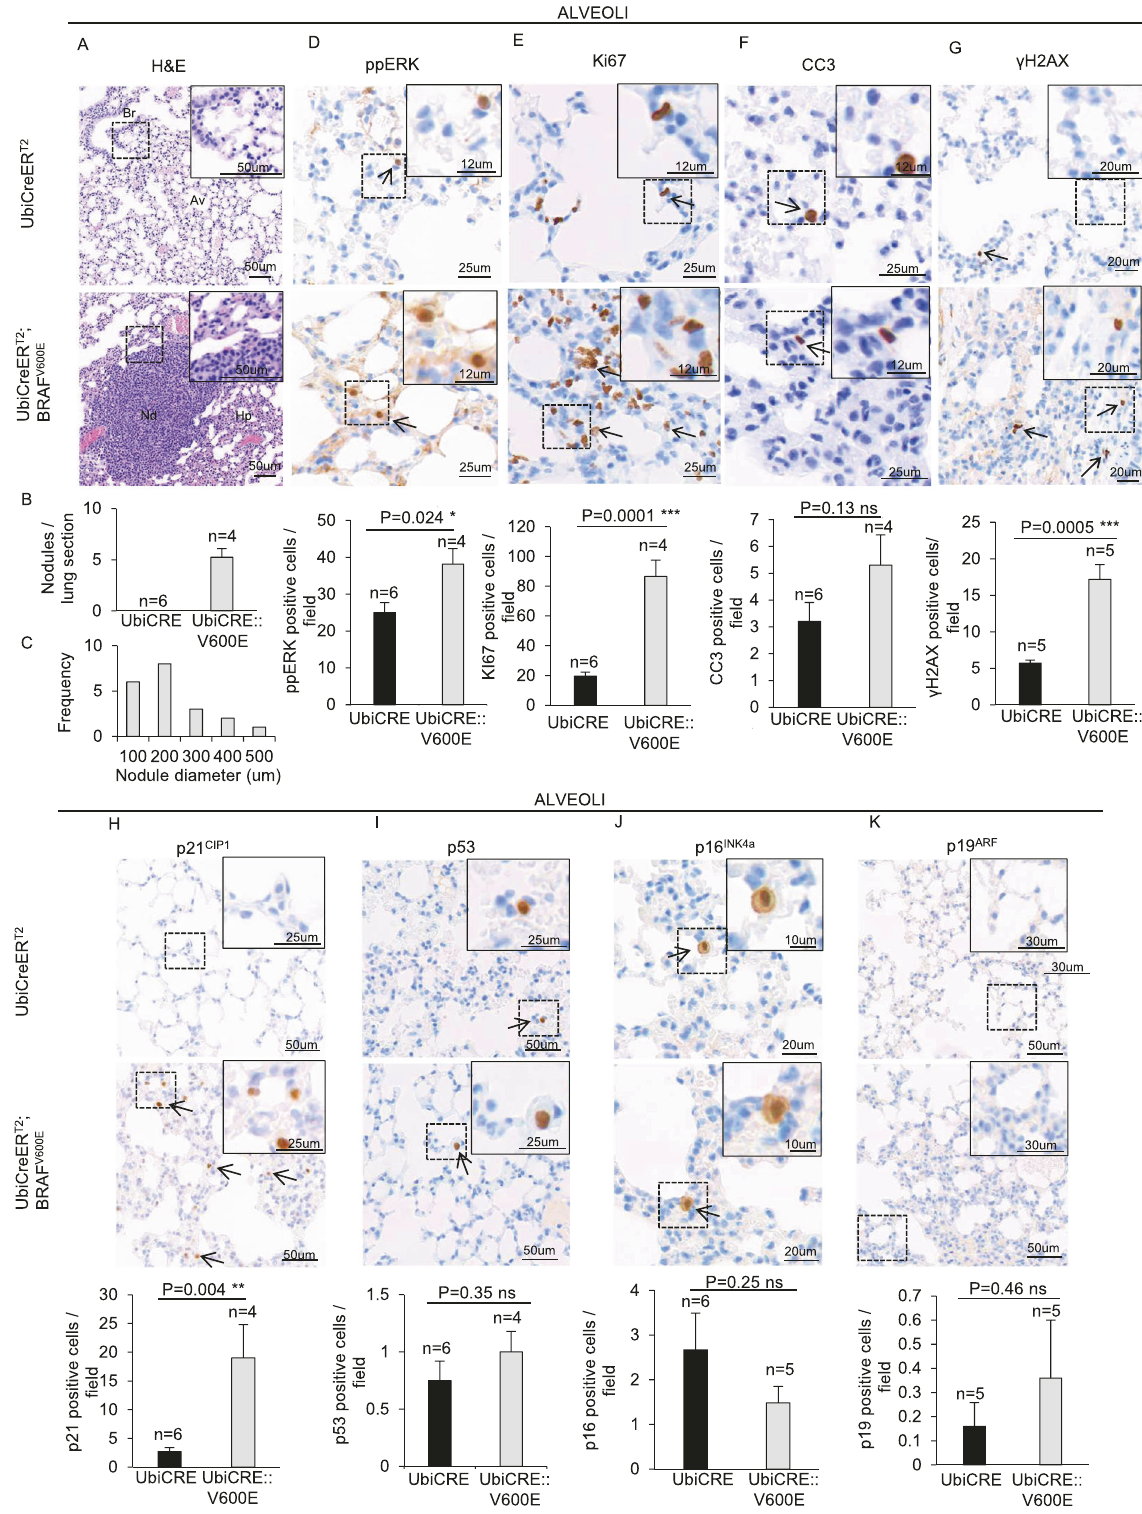
Fig. 2 Early effects of BRAF V600E expression in the alveolar parenchyma. Representative images and quanti fi cations showing A – C H&E staining, D ppERK, E Ki67, F CC3, G γ H2AX, H p21 CIP1 , I p53, J p16 INK4a , K p19 ARF immunostainings in lung sections from BRAF V600E and control mice. Quanti fi cations were performed on fi ve different areas of the sections in a random way. Data are expressed as mean ± SEM; n = animals per group. * P < 0.05; ** P < 0.01; *** P < 0.001, ns = not signi fi cant. (T Student ’ s test unpaired). Arrows point to selected positive cells for the indicated marker. Legend for fi gure A : Br: bronchus, Av: Alveolus, Nd: hyperplastic nodule, Hp: hyperplastic alveolar epithelium. Legend for I : the arrows point to neutrophils. Figures B and C represent the quanti fi cations of the nodules shown in A . Insets: magni fi cations of areas inside dashed squares.